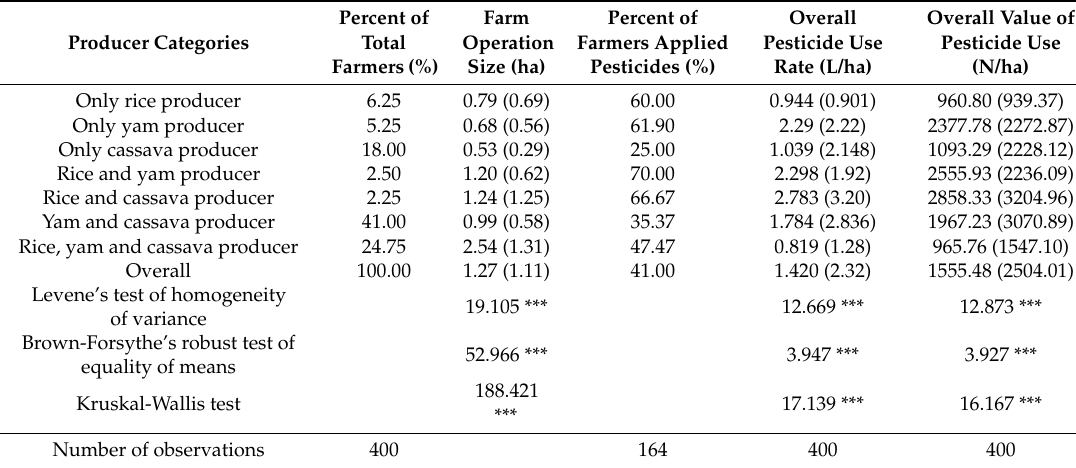
Table 3. Extent of pesticide use in multiple food